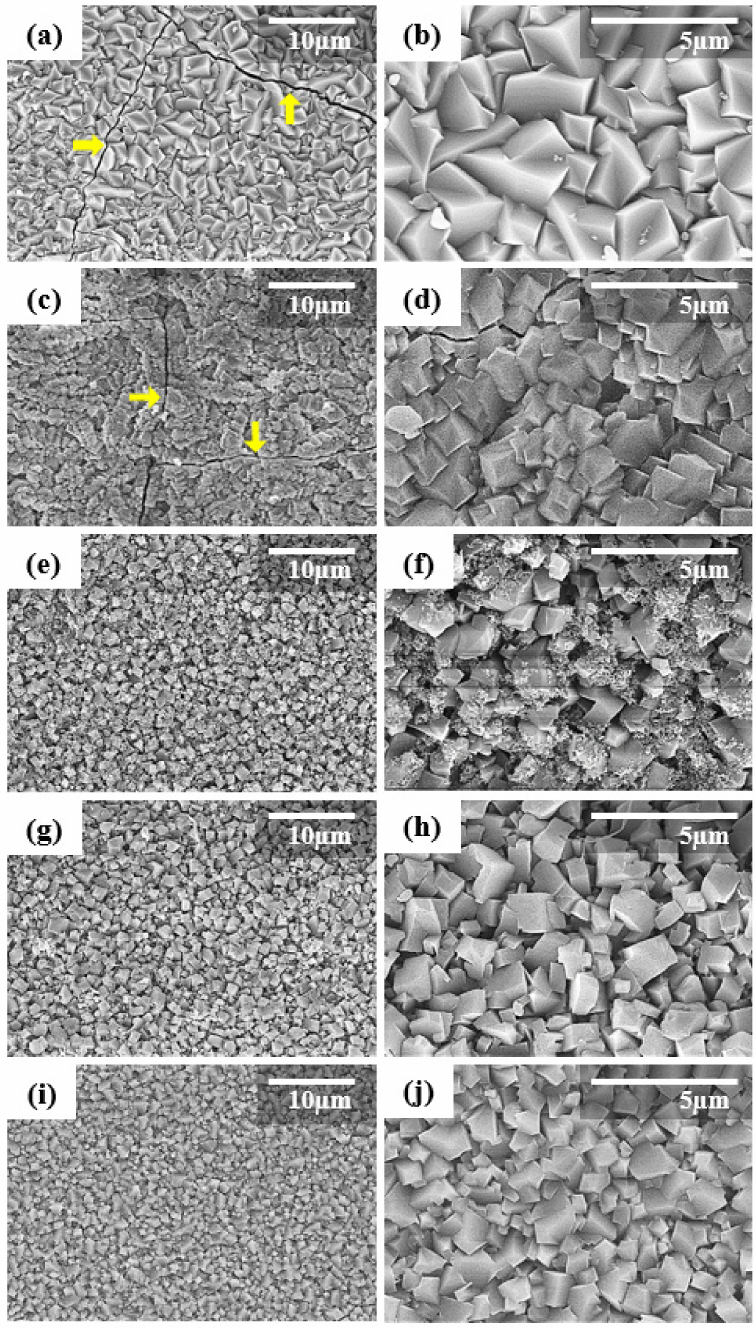
Figure 7. Different magnification top-surface SEM images of the synthesized CHA zeolite membranes using planetary-milled ( a , b ) S1, ( c , d ) S2, ( e , f ) S3, ( g , h ) S4, and ( i , j ) S5 seed samples. The yellow arrow shows site of cracks in the zeolite